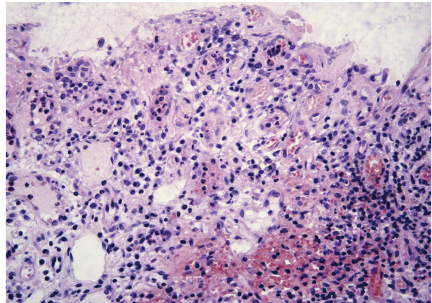
Figure 4: Small intestinal epithelium, impaired by extensive infil- tration with plasmatic cells and lymphocytes. Optical histology, haematoxilin-eosin staining. Original magnification 100x. Courtesy